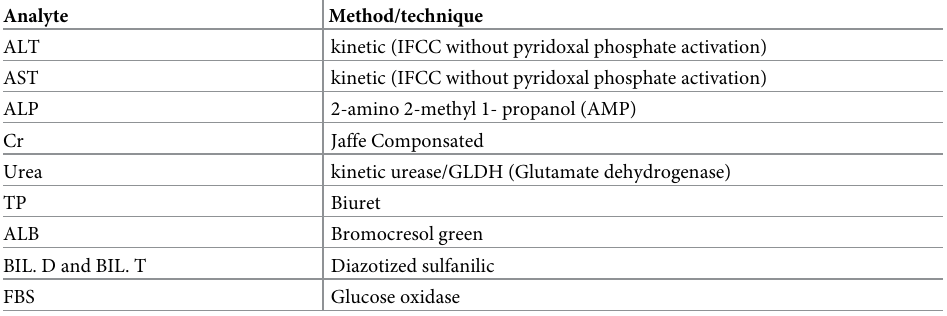
Table 1. Methods used for analytes of clinical chemistry to determine the reference interval of apparently healthy Adolescents of Mekelle city, Tigrai, Ethiopia